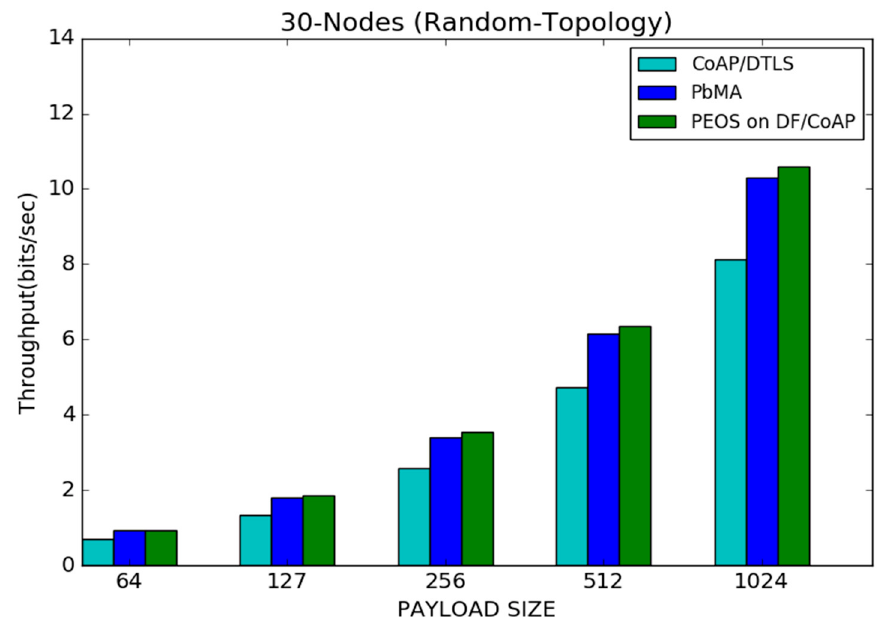
Figure 7. Payload size vs. throughput for 30 node topology.